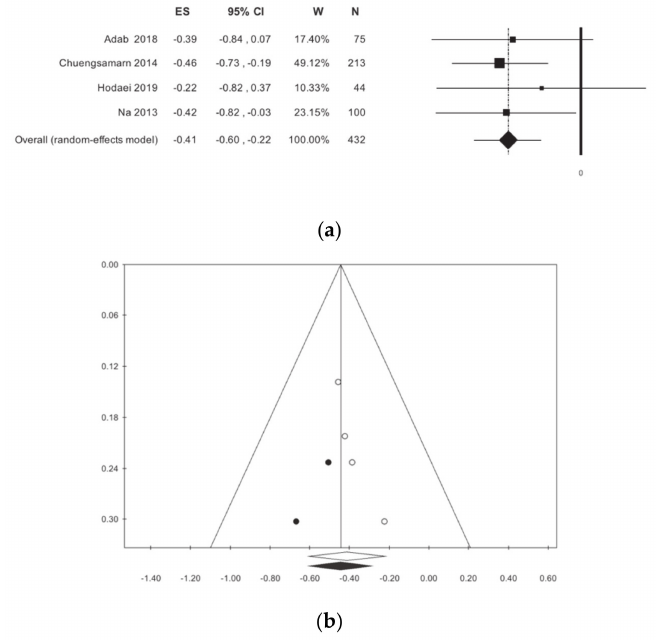
Figure 4. Meta-analysis results according to homeostasis model assessment (HOMA): ( a ) forest plot ( b ) funnel plot.